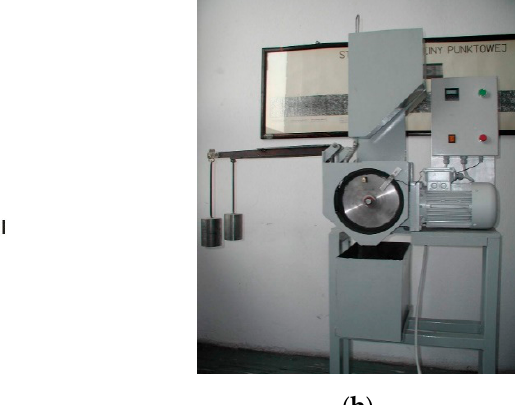
Figure 3. Schematic diagram of ASTM G65-00 Procedure A abrasive wear resistance test ( a ) and apparatus overview ( b ).